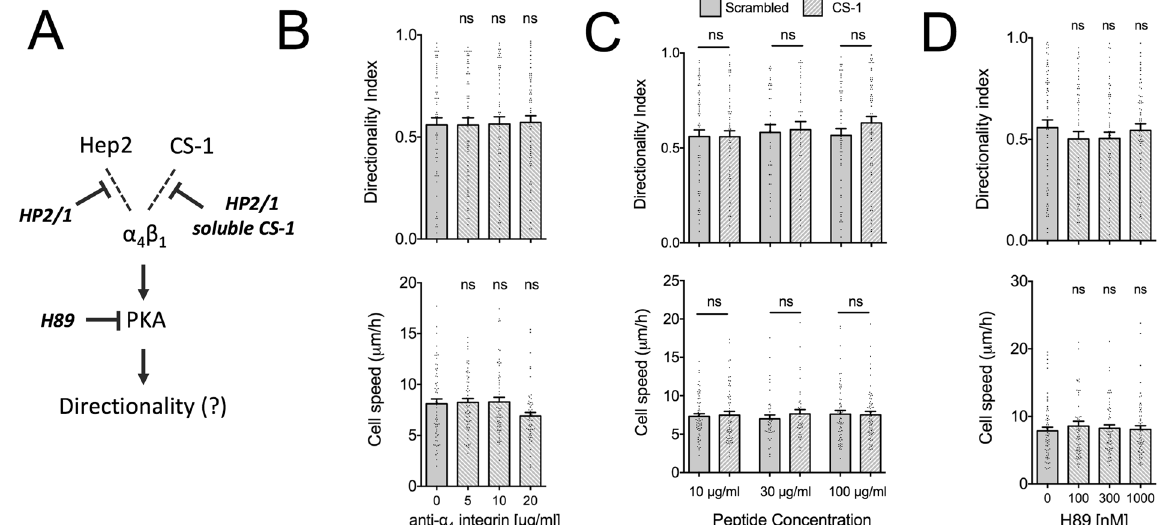
Figure 2. Integrin α 4 β 1 blocking or PKA inhibition do not affect cell speed and directional persistence of fibroblast migration on FN. ( A ) Model of potential α 4 β 1 -mediated regulation of directional persistence in migration. Dashed lines indicate potential binding to integrin ligands and blocking reagents used are shown in bold. ( B ) REF speed and directionality index on FN-coated substrates (10 μ g/ml) were not affected by the presence of blocking antibody against integrin α 4 β 1 (clone H2P/1). Values in presence of antibody were compared to the control condition using one-way ANOVA analysis (N exp = 3; n = 60). ( C ) REF speed and directionality index on FN-coated substrates (10 μ g/ml) were not affected by the presence of CS-1 peptide, compared to a scrambled control. Values were compared using a Mann-Whitney test (N exp = 3; n = 60 for peptide concentrations of 10 and 100 μ g/ml and N exp = 2; n = 40 for 30 μ g/ml). ( D ) REF speed and directionality index on FN-coated substrates (10 μ g/ml) were not affected by the presence of the soluble PKA inhibitor H89. Values in presence of H89 were compared to control conditions (same amount of DMSO as used for the highest H89 concentration) using one-way ANOVA analysis (N exp = 3; n = 57–60). Mean ± s.e.m. are presented. ns: not